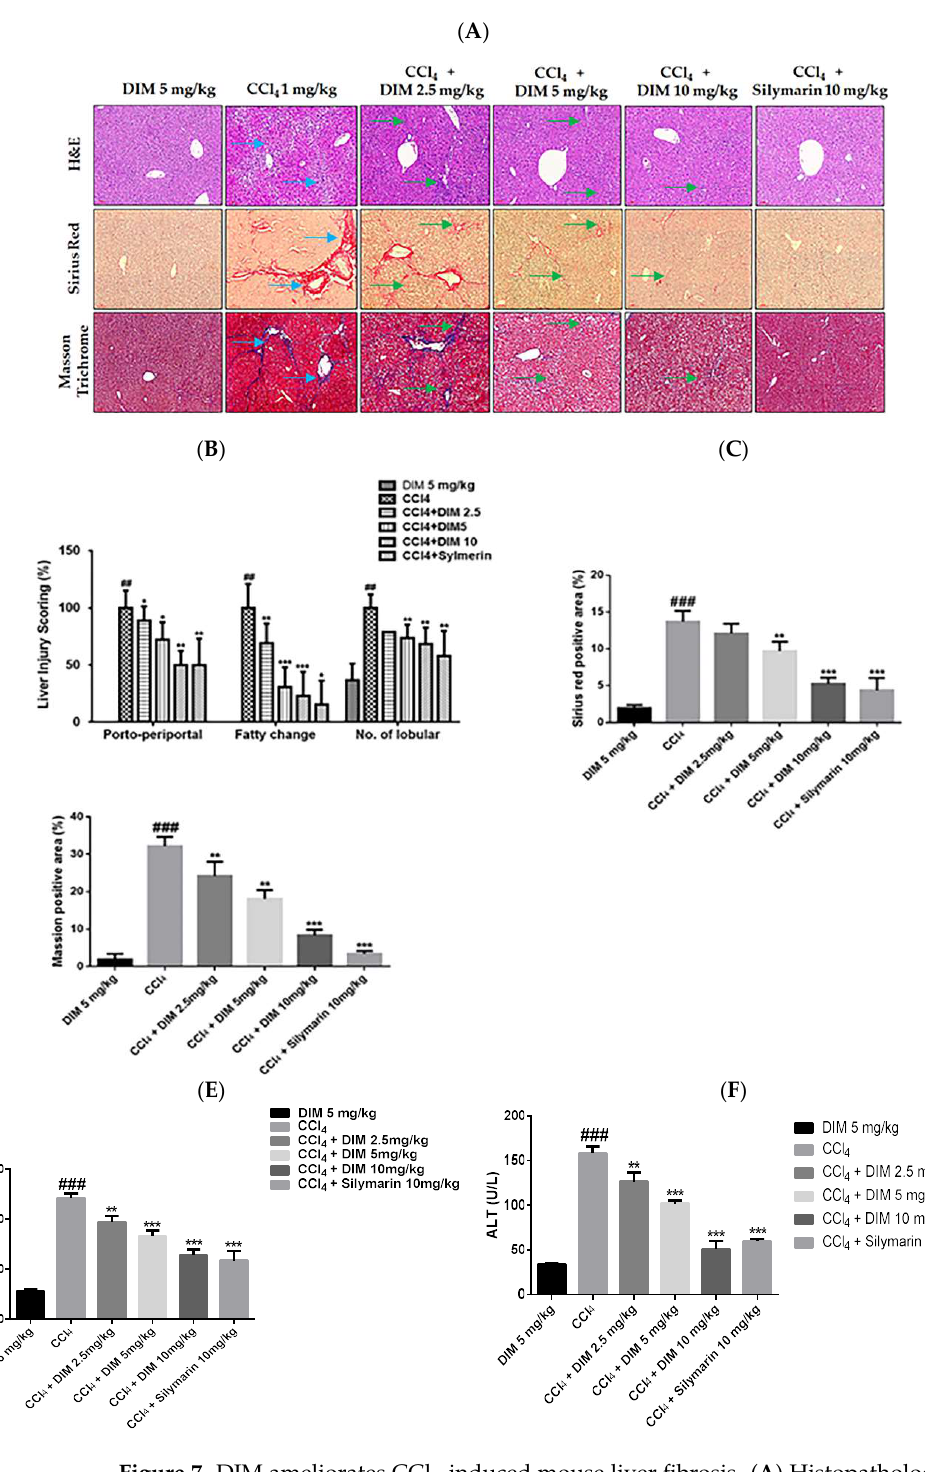
Figure 7. DIM ameliorates CCl 4 -induced mouse liver fibrosis. ( A ) Histopathological damage and fibrosis levels examined by H&E, Sirius Red, and Masson staining of liver; blue arrow indicates the levels of injury after CCl 4 treatment, and green arrow indicates the recovery after DIM treatment.